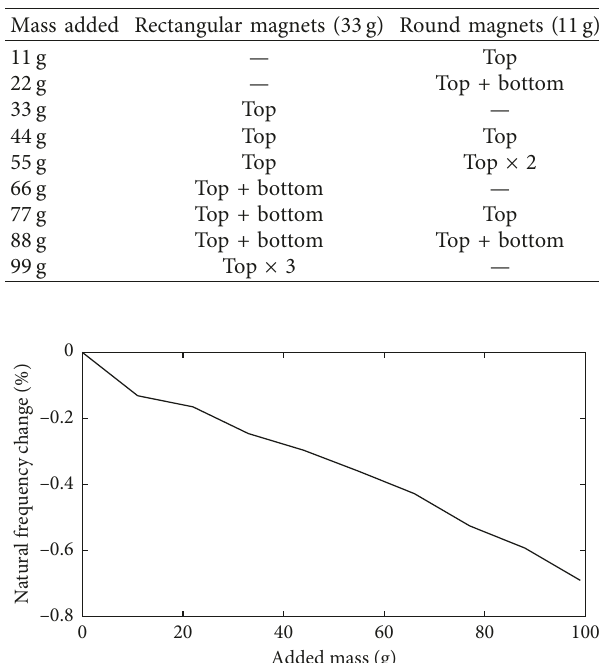
Figure 4: The change in the Lipschitz exponent due to damage severity. Table 2: The position of the masses added to the blade for the different damage cases in the bladed disk experiment.